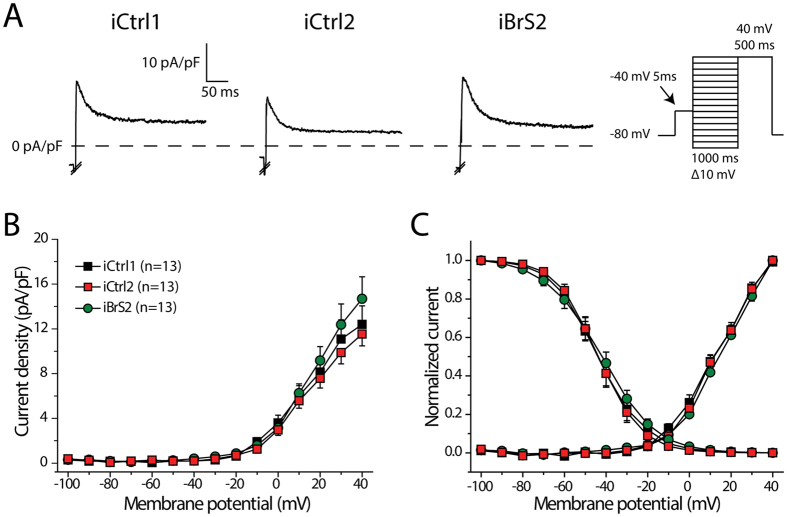
Transient outward potassium current (Ito) in hiPSC-CMs from iCtrl1, iCtrl2 and iBrS2.(A) Representative trances of Ito elicited at a test potential of +40 mV. Inset shows the voltage clamp protocol, in which a prepulse of 5 ms to −40 is applied to activate and inactivate INa. Please note that INa was cut-off in the depicted examples. (B) I-V relationships of Ito. No statistical differences are present (One-Way Anova, p > 0.05) (C) Voltage dependence of activation and inactivation.